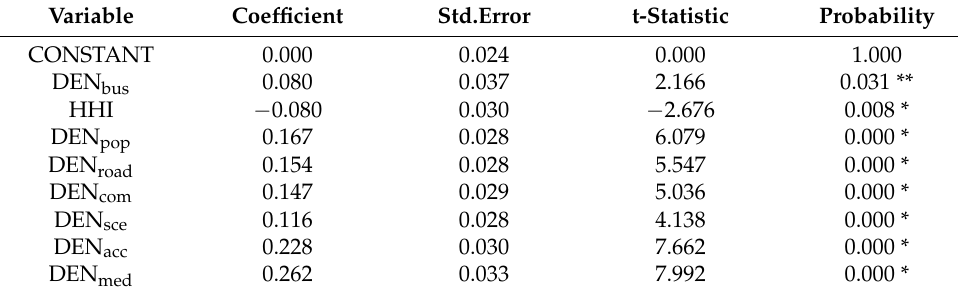
Table 4. The OLS regression result of independent variables. Variable